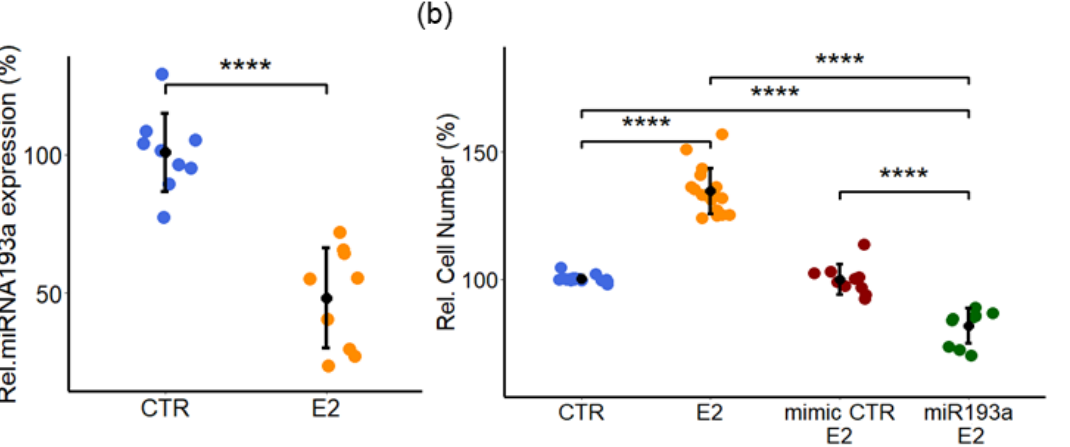
Figure 5. E2 induces LEC growth by downregulating miR193a-3p expression. ( a ) Cells grown in complete media were starved in a steroid-free medium prior to 72 h of treatment with 10 nM E2. Total RNA was extracted and relative miRNA expression levels were determined by RT-qPCR using the TaqMan miRNA assay. The results were normalized to U48 and U49. ( b ) Cells were treated with 10 nM E2 or its vehicle (DMSO) as the control (CTR). Cells were transfected with either the miRNA mimic control or miR193a-3p prior to treatment with 10 nM E2 or the vehicle. Proliferation was assessed by counting LECs. Data represent the mean ± SD. Experiments were performed at least three times in triplicates or quadruplicates. p < 0.0005 **** compared to the respective control.